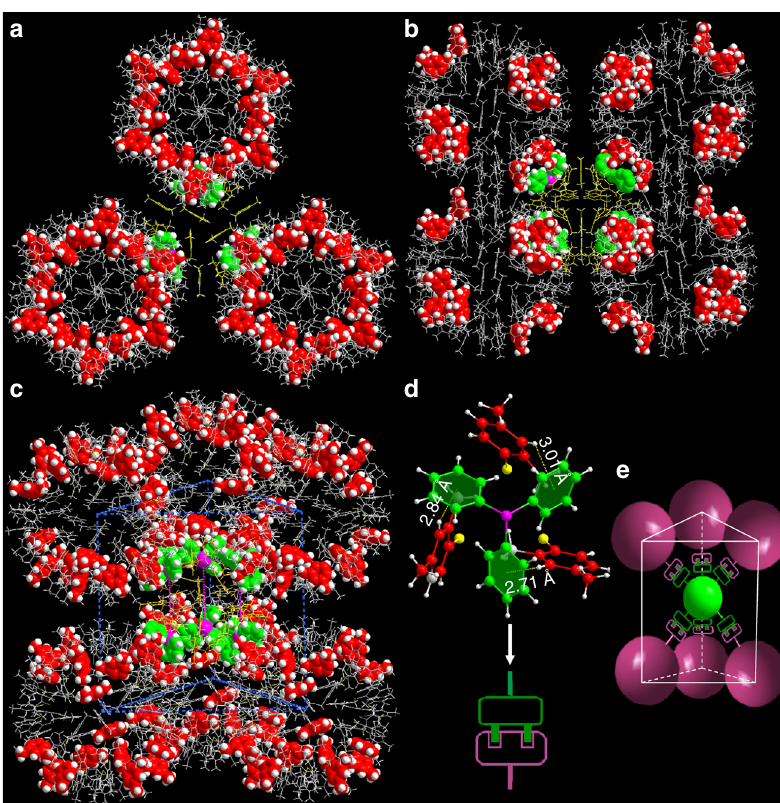
Fig. 3 Interparticle self-assembly directed by the ligand anisotropy of surface patterns. a – c Arrangement of surface ligands of both (AuAg) 267 and (AuAg) 45 in the crystal lattice: top view ( a ) and side view ( b ) and ( c ). d The C-H ⋅⋅⋅ π interactions among the interparticle ligands, similar to tightly jointed plugs and sockets. e Scheme showing directional packing of binary composites via anisotropic ligand surface. Color code: magenta P, gray, red, gold, and green C, white